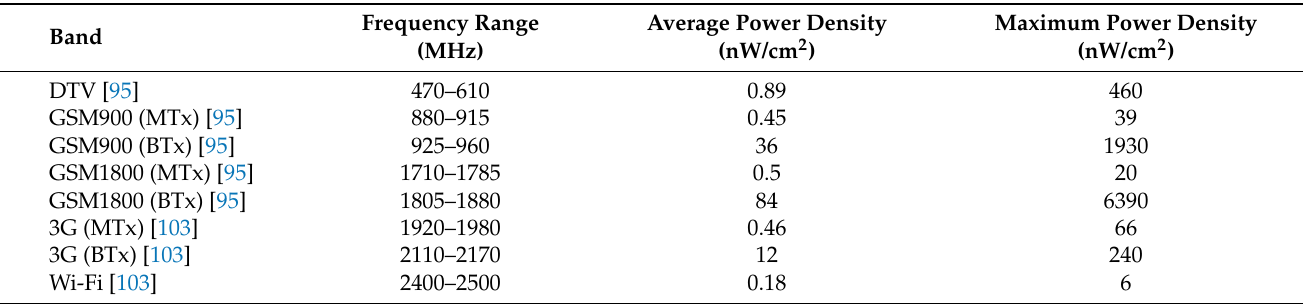
Table 5. Power densities of ambient RF power harvesting sources in different frequency